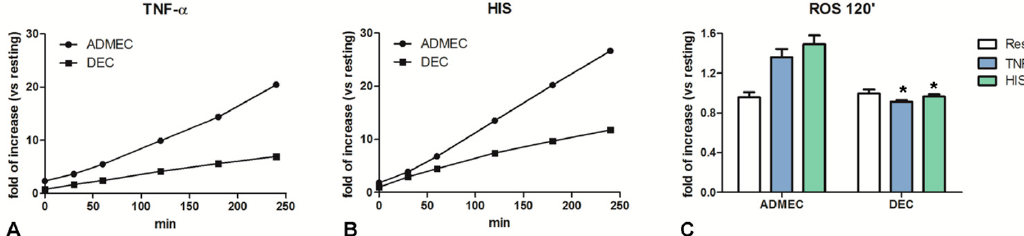
Figure 3. Production of intracellular ROS by endothelial cells. ROS production by endothelial cells exposed to TNF- α ( A ) or HIS ( B ). Following pre-treatment with TNF- α (100 ng/mL) or histamine (HIS; 0.1 µM), ECs were stained with Ampliflu Red for the evaluation of H 2 O 2 production after 30, 60 120, 180 and 240 min. ( C ) Histograms represent the production of intracellular ROS by endothelial cells stimulated with TNF- α or HIS after 120 min. The data represent the mean ± SD of triplicate samples from five separate experiments; * p <